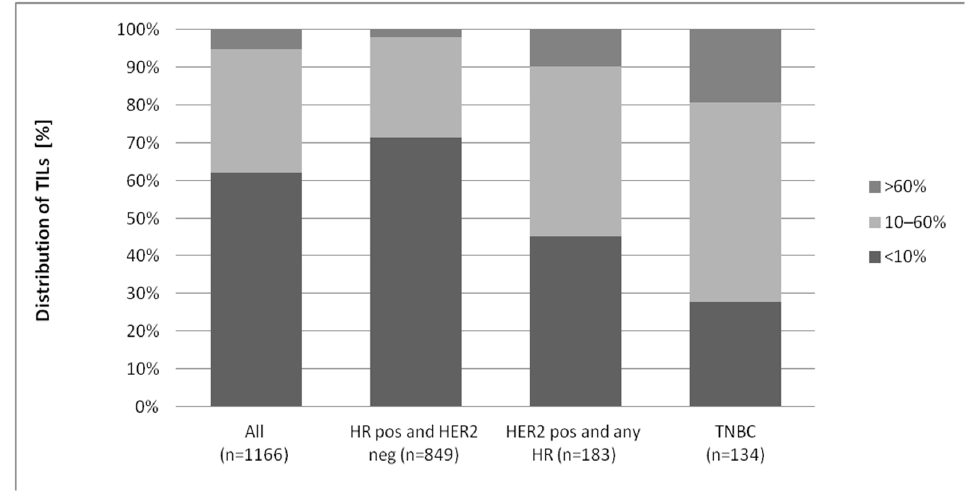
Figure 2. Distributions of TILs ( n = 1166).